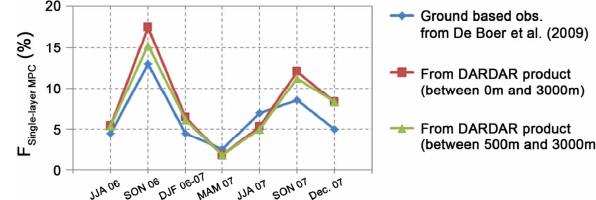
Figure 3. Seasonal occurrence of MPCs over the Eureka station from June 2006 to December 2007 from ground-based observations (blue line from De Boer et al., 2009) and from DARDAR product (green and red lines).